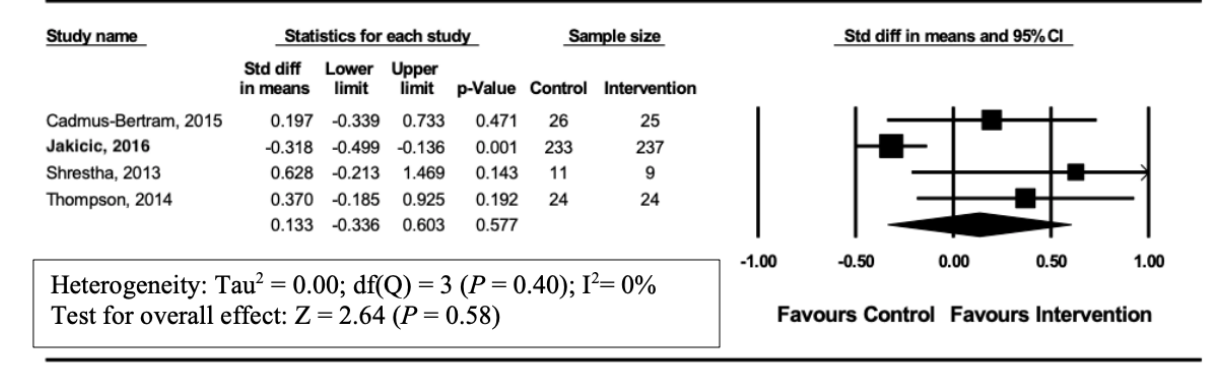
Figure 4. Forest plot of standardized mean difference (95% Cl) in the effect of wearable trackers on weight loss for intervention and control group.